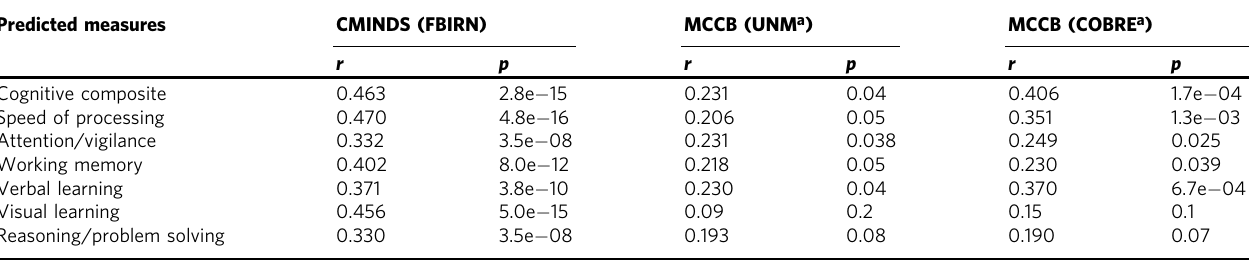
Table 1 Prediction results for multiple cognitive domains using the four neuromarkers Predicted measures CMINDS (FBIRN) MCCB (UNM a ) MCCB (COBRE a ) Cognitive